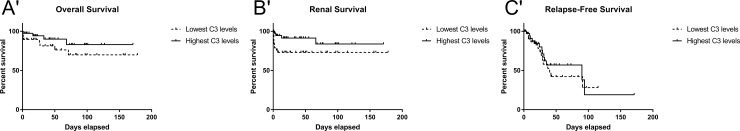
Kaplan-Meier estimate of overall (A'), renal (B') and relapse-free (C') survival rates in patients with granulomatosis with polyangiitis or microscopic polyangiitis, according to the low normal or high normal plasma C3 levels (relative values) performed before treatment, based on the median value of C3 levels observed in the whole cohort (p = 0.23, 0.07 and 0.60, respectively).